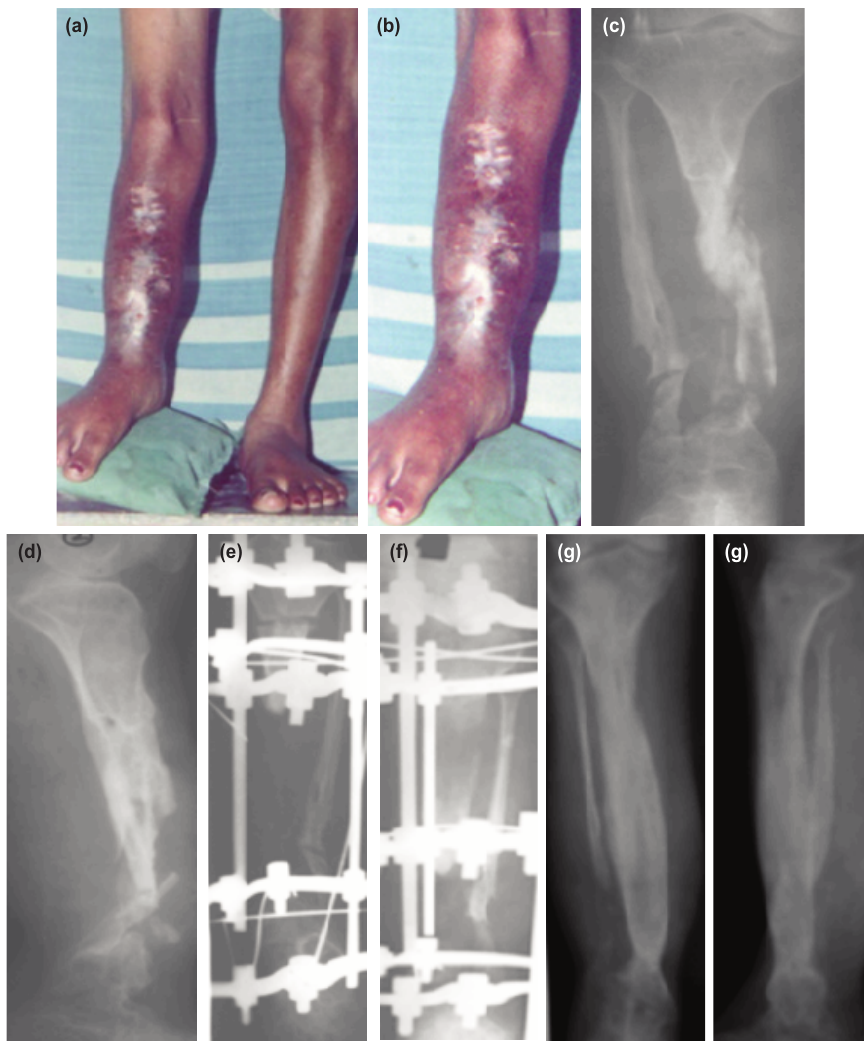
(a) Pre-op clinical photo of a case of infected non-union tibia with LLD. (b) Magnified image showing infected part with sinuses. Fig. 5: (c) Pre-op AP view radiograph showing infected non-union. (d) Pre-op lateral view radiograph showing infected non-union. (e) After radical debridement and corticotomy with massive bone gap. (f) Subsequent radiograph during bone transport showing regenerate bone. (g) Final follow-up AP view radiograph showing union and regenerate. (h) Final follow-up Lat view radiographs showing union and